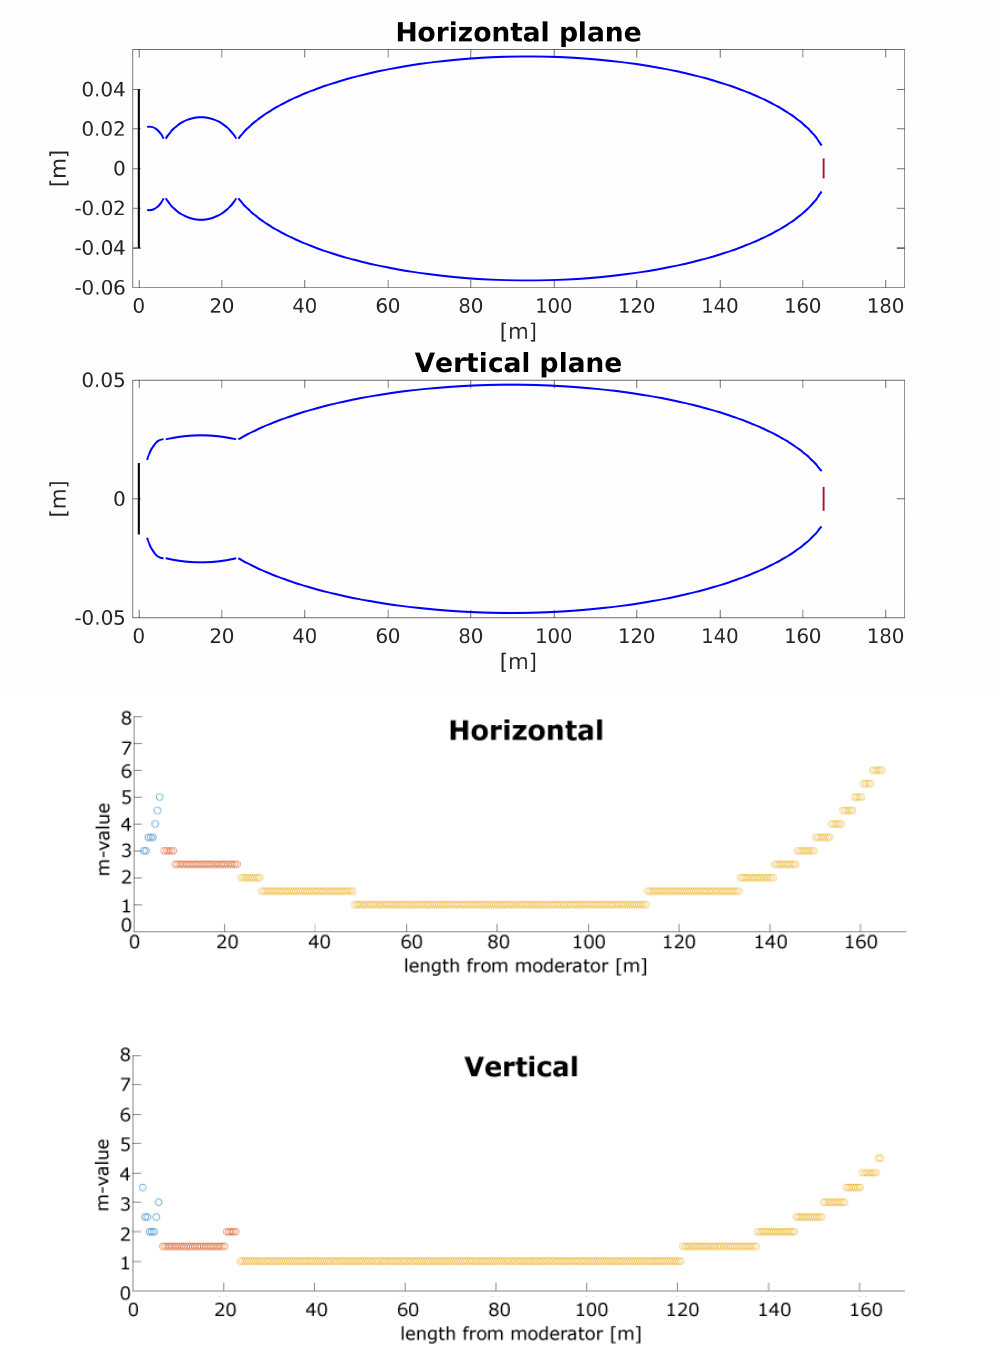
Figure A3. Benchmark 2. Guide dimensions and coating values. Top panels: Schematic drawing of the double-pinhole guide, optimized for the wavelength band 1.5–4.0 Å. The figures are not to scale. Bottom panels: The optimized m-distribution in the horizontal and vertical directions,